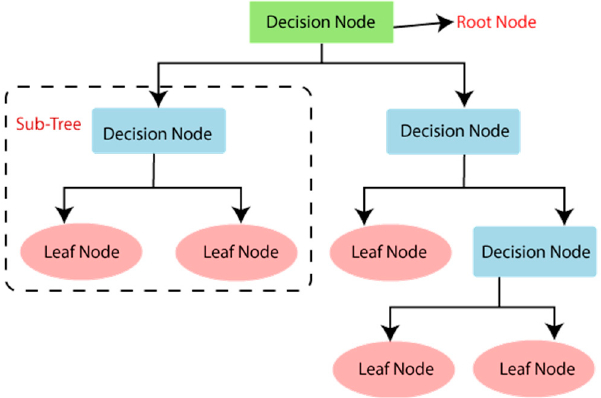
Figure 1 . Decision tree algorithm [13]. Figure 1. Decision tree algorithm [13].